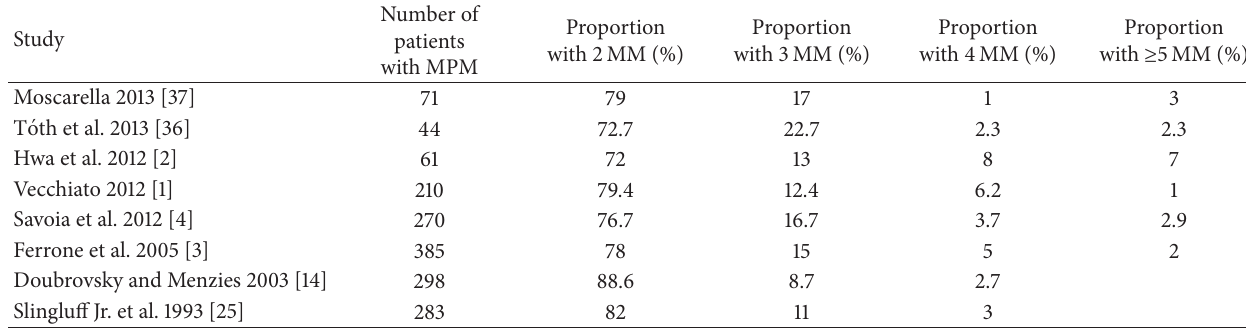
Table 3: Studies with several primary